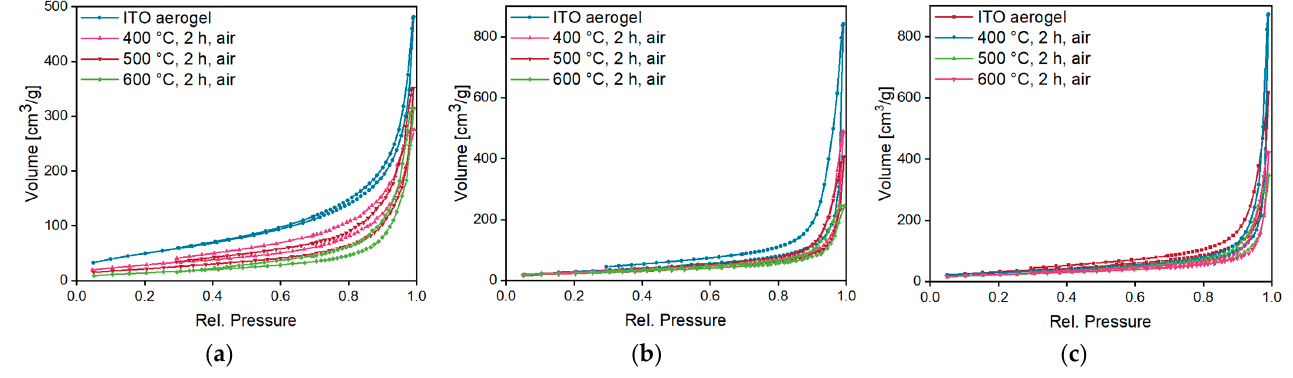
Figure 11. Nitrogen sorption isotherms of ITO aerogels A ( a ), B ( b ) and C ( c ) before and after an- nealing at temperatures of 400–600 °C in air (see Figure S11 for the corresponding BET plots).